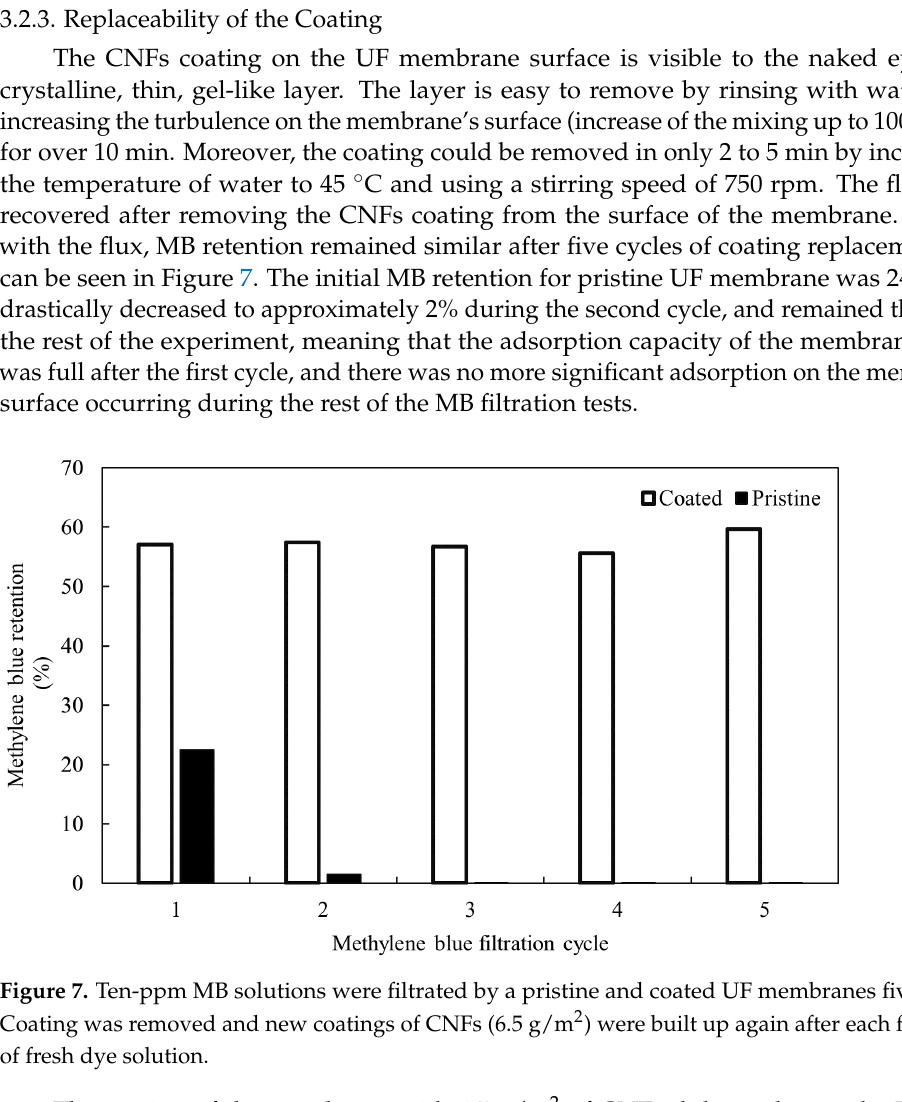
Figure 8. Membrane performance in terms of PWP during coating with 6.5 g/m 2 of CNFs and coating removal cycle. The replaceability of the coating (6.5 g/m 2 ) on the membrane displayed excellent re- sults by maintaining approximately 57% and 48 L/m 2 hbar of dye retention and PWP, re- spectively. In summary, from the results shown in this study, it can be deduced that CNFs prepared by the method proposed can be used to modify the surface of regenerated cel- lulose UF membranes. Additionally, the coating can be easily removed and created again on the membrane surface. Moreover, the capacity to enhance the removal of the dye MB in the UF process has been proved. Taken together, the adsorptive properties of CNFs, and the approach used in this study, formulates the hypothesis that coated UF membranes